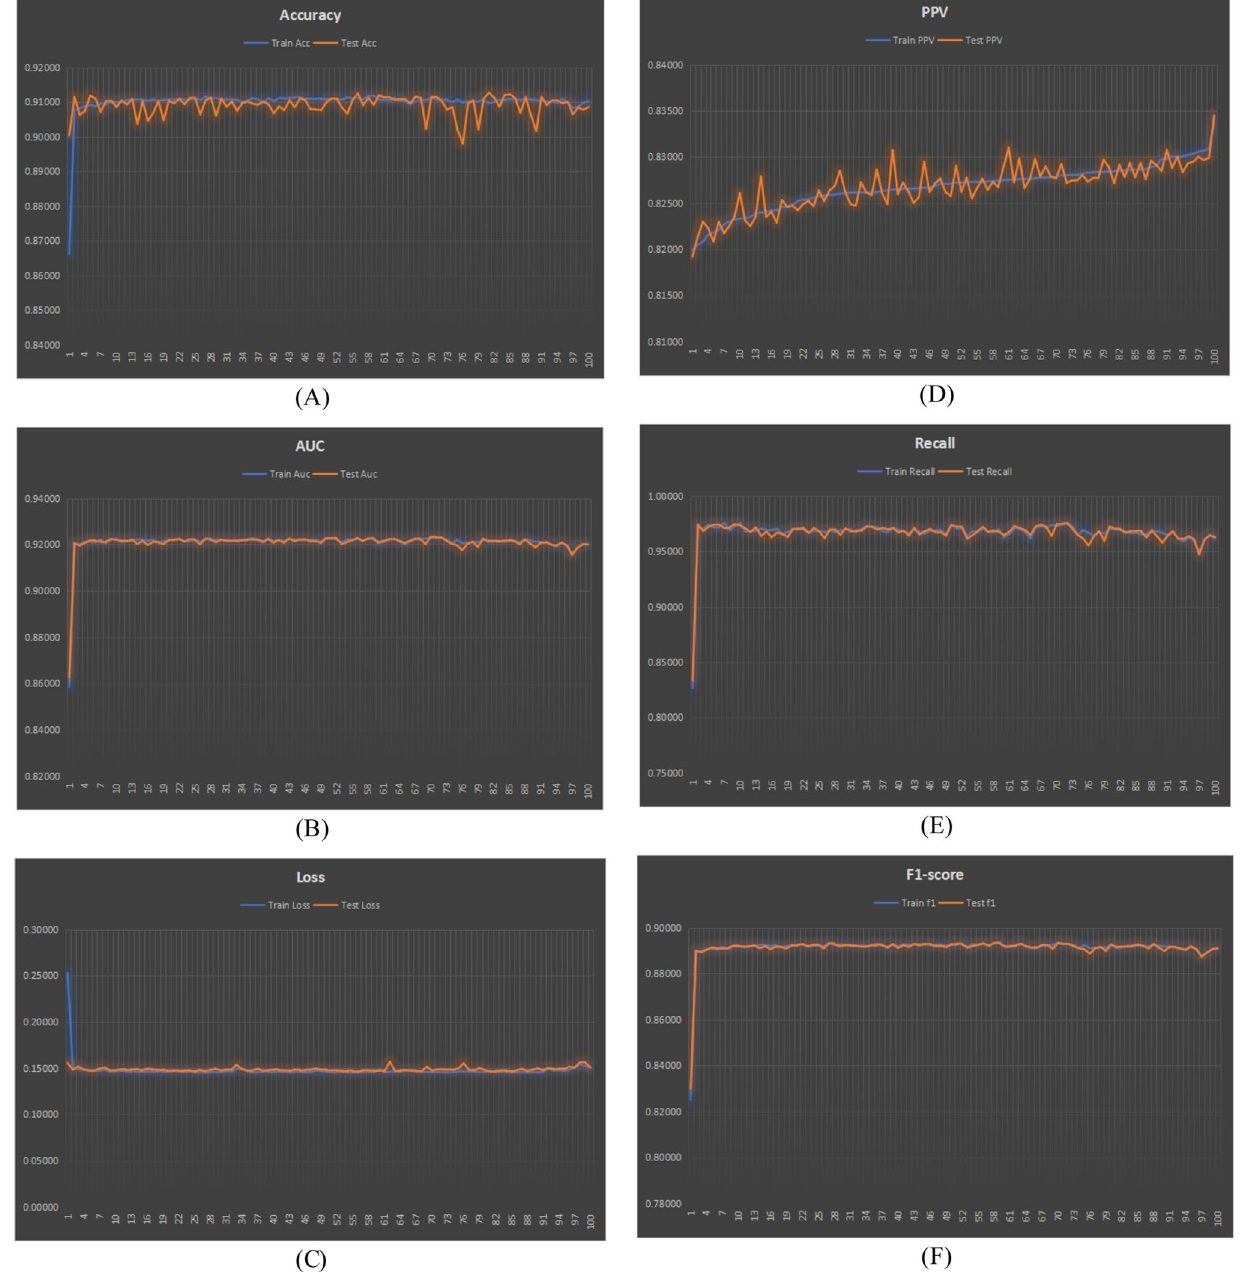
Fig. 2 The variation score of accuracy A , AUC B , loss C , precision D , recall E and F1-score F in the training and testing